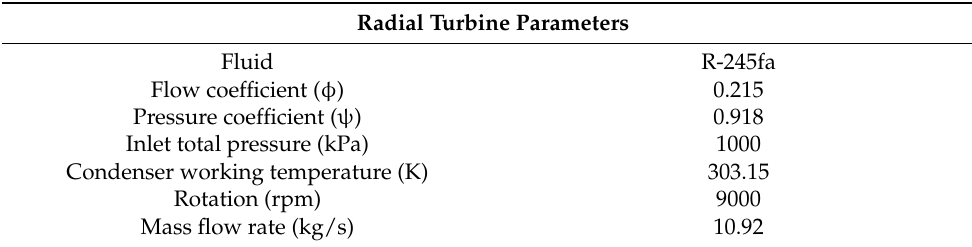
Table 1. Input parameters of the radial turbine design.